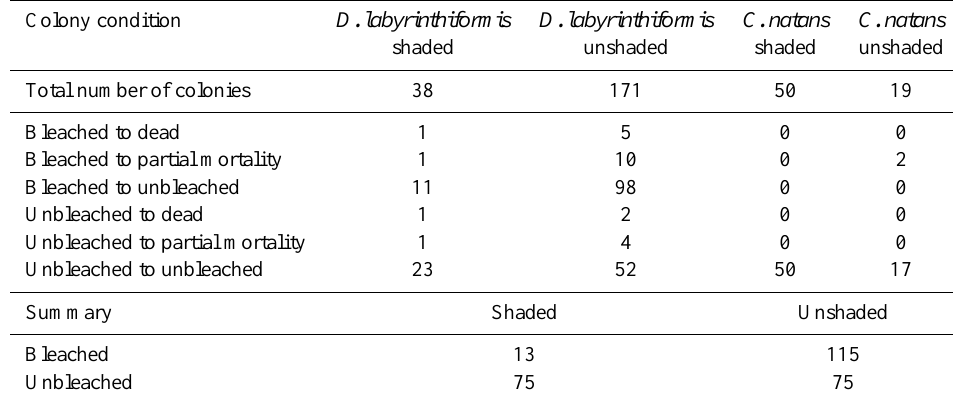
Table 8. Condition of colonies of Diploria labyrinthiformis and Colpophyllia natans during 2010–2011. Colony condition shaded unshaded shaded unshaded